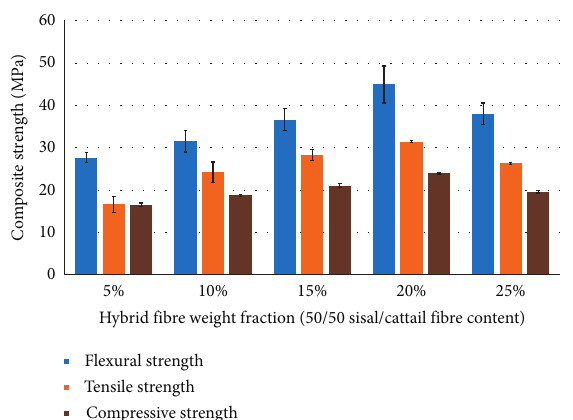
Figure 2: Flexural, tensile, and compressive strengths of hybrid composites at a constant fibre blend ratio of 50/50 and varying hybrid fibre weight